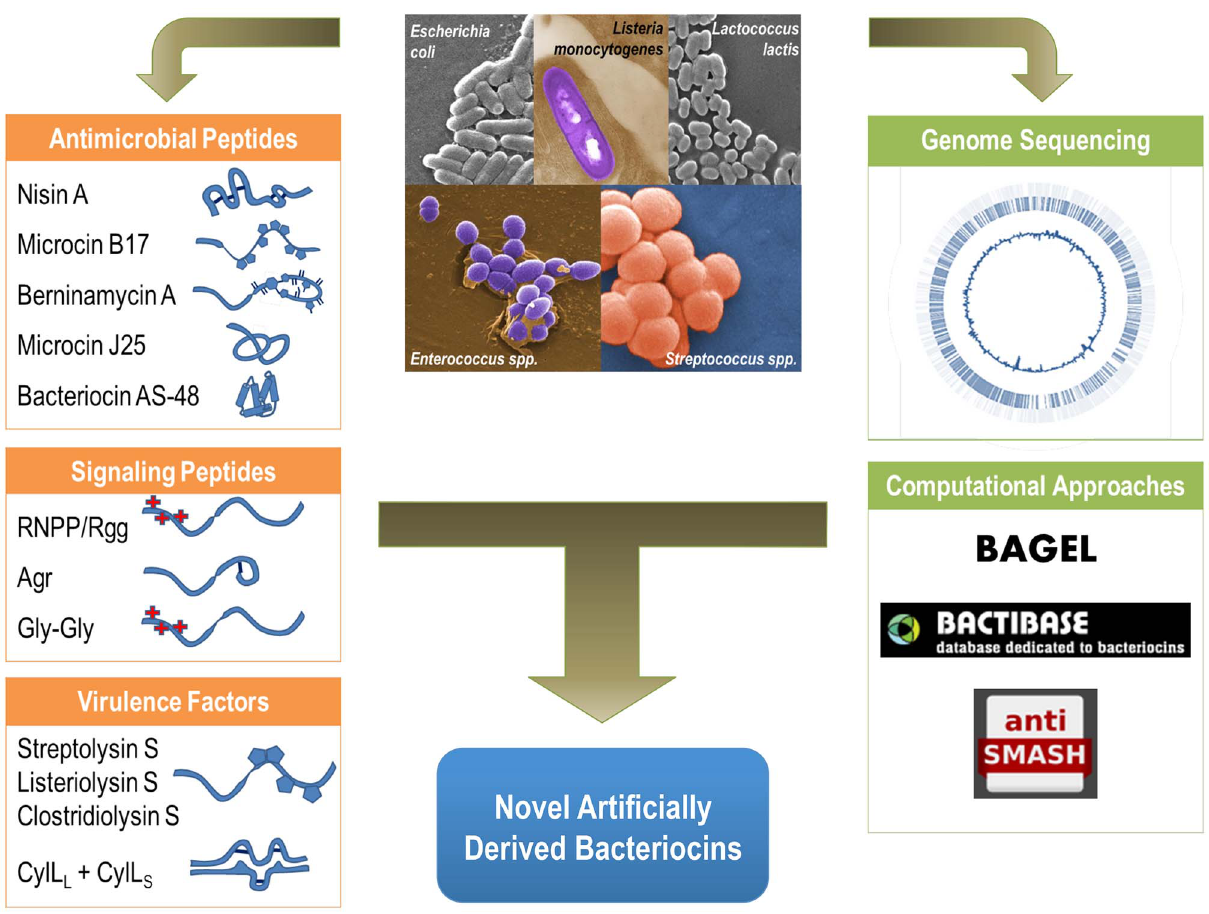
Figure 1. Functional diversity of ribosomally produced bacterial peptides. Bacterial peptides produced by both gram-positive and gram- negative bacteria include antimicrobial peptides such as Nisin and Microcin B17, known host virulence factors such as the Streptolysin S-like cytolysins, and the peptide cytolysin from E. faecalis . Bacterial peptides that structurally resemble bacteriocins are also utilized as signaling molecules. Computational and genomic approaches, such as BAGEL, BACTIBASE, and Anti-SMASH, can be combined with genomic data to catalog and discover new ribosomally produced bacterial peptides. Combining computational approaches with experimental data can guide the development of novel antimicrobials and artificially derived peptides with specific functions and targets.